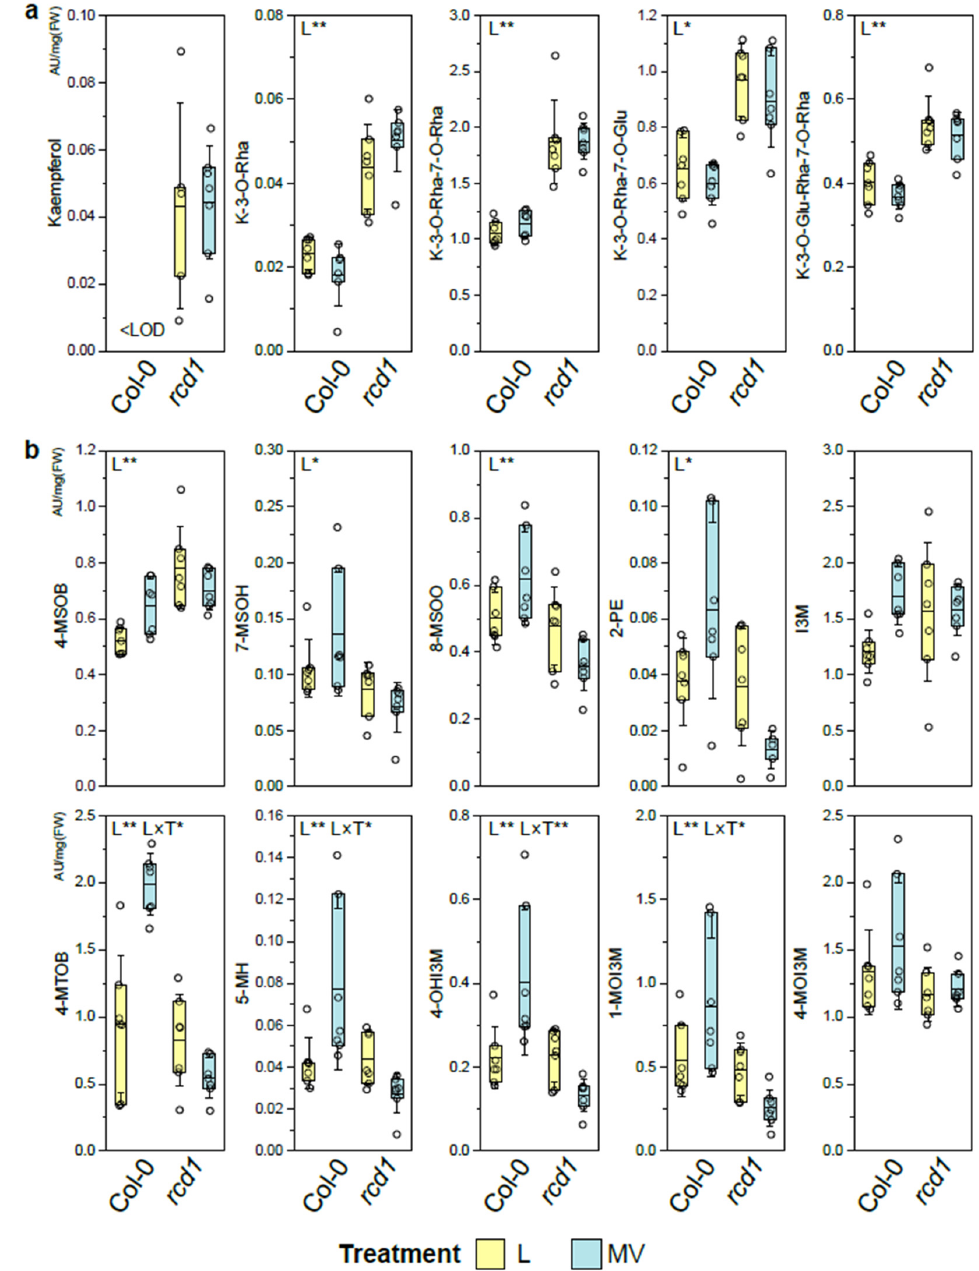
Figure 2. The levels of ( a ) flavonoids and ( b ) glucosinolates in Arabidopsis thaliana Col-0 wild type and in rcd1 mutant plants in control/light conditions (Ctrl/L) and after methyl viologen (MV) treatment. The main effects of plant line (L) and treatment (T) and their interaction (L × T) were tested with two-way ANOVA (FDR-adjusted p -value < 0.05 *, <0.01 **); the details of the statistical results are in the supplementary Table S1i. Dots represent data points ( n = 4–7); the box represents 25 and 75 percentiles; the line marks the mean and the whiskers the standard deviation. The levels are arbitrary units (AU/mg [FW]), peak area normalized with internal standard, and samples fresh weight (FW). The metabolite levels below limit of detection are marked as <LOD. K = kaempferol, Rha = rhamnoside, Glu = glucoside, 4-MSOB = 4-methylsulfinylbutyl-, 7-MSOH = 7-methylsulfinylheptyl-, 8-MSOO = 8-methylsulfinyloctyl-, 2-PE = 2-phenylethyl-, I3M = indolyl-3-methyl-, 4-MTOB = 4-methylthiobutyl-, 5-MH = 5-methylhexyl-, 4-OHI3M = 4-hydroxy-indolyl-3-methyl-, 1-MOI3M = 1-methoxy-indolyl-3-methyl-, 4-MOI3M = 4-methoxy-indolyl-3-methyl glucosinolate (GLS).